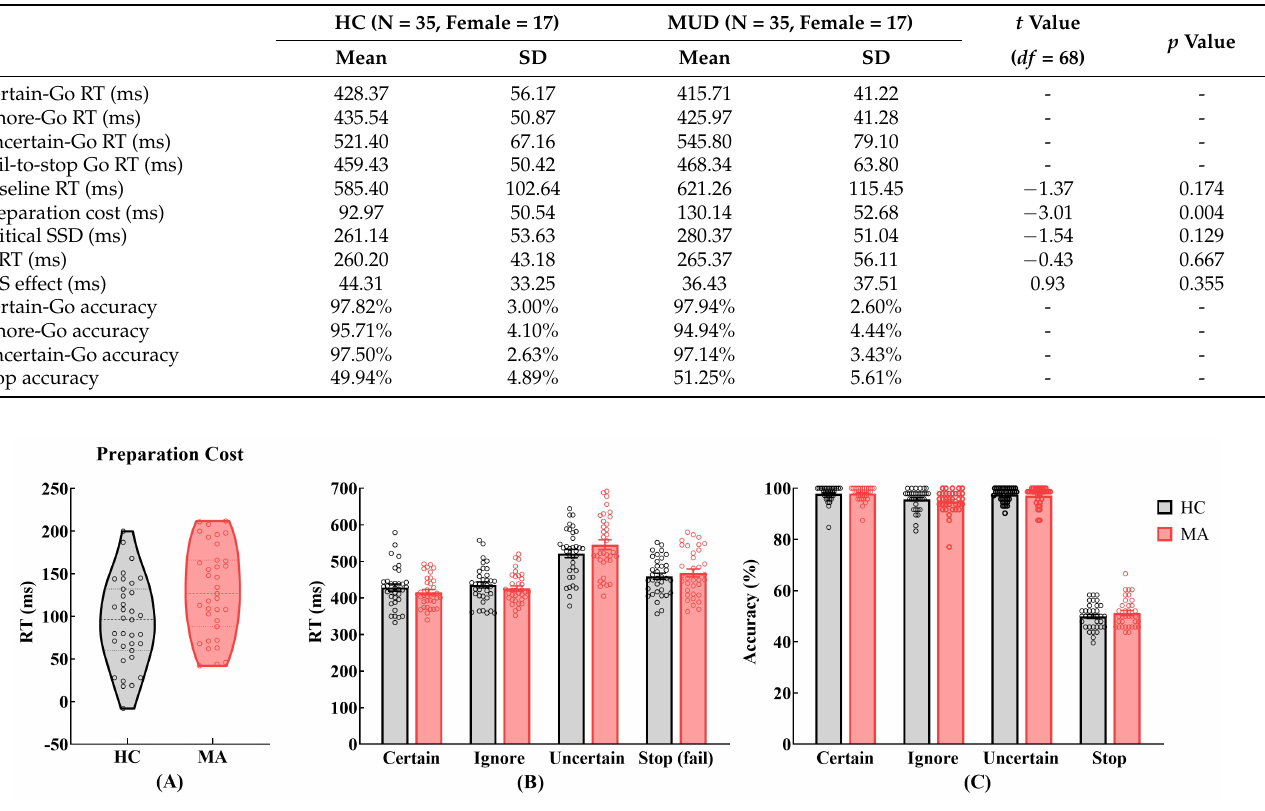
Figure 2. Behavioral results on the C-SST. The black border, gray-filled violin plot and bars represent the HC results, and the red border, pink-filled violin plot and bars represent the MUD results. The circles within each violin plot and bar represent data for individuals datapoints. ( A ) Violin plots reveal that the preparation cost in the MUD group was significantly slower than that in the HC group ( p < 0.01). The upper, middle, and lower dashed lines within each violin plot represent the upper, middle, and lower quartiles, respectively. ( B ) The grouped bar chart presents the RTs under the four contexts (Certain-Go, Ignore-Go, Uncertain-Go and Fail-to-Stop) for the HC and MUD groups. ( C ) The grouped bar chart represents the accuracy in the four contexts (Certain, Ignore, Uncertain and Stop) for the HC and MUD